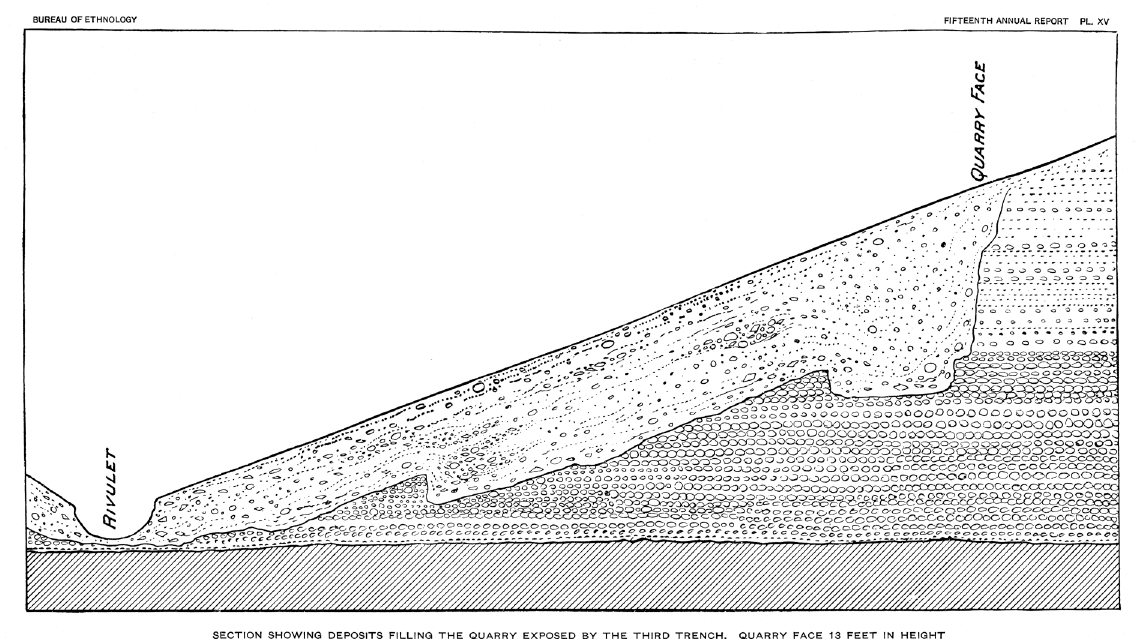
Figure 3. Colluvial deposits at Piney Branch. After Holmes 1897: plate XV. [Original caption: Section showing deposits filling the quarry exposed by the third trench. Quarry face 13 feet in height]